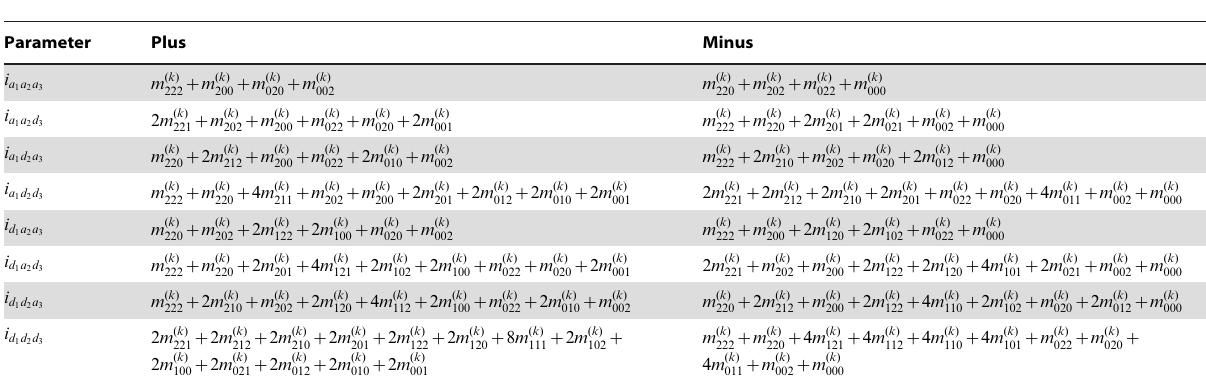
Table 3. The x 2 test statistics for the three-way epistatic effect parameters.